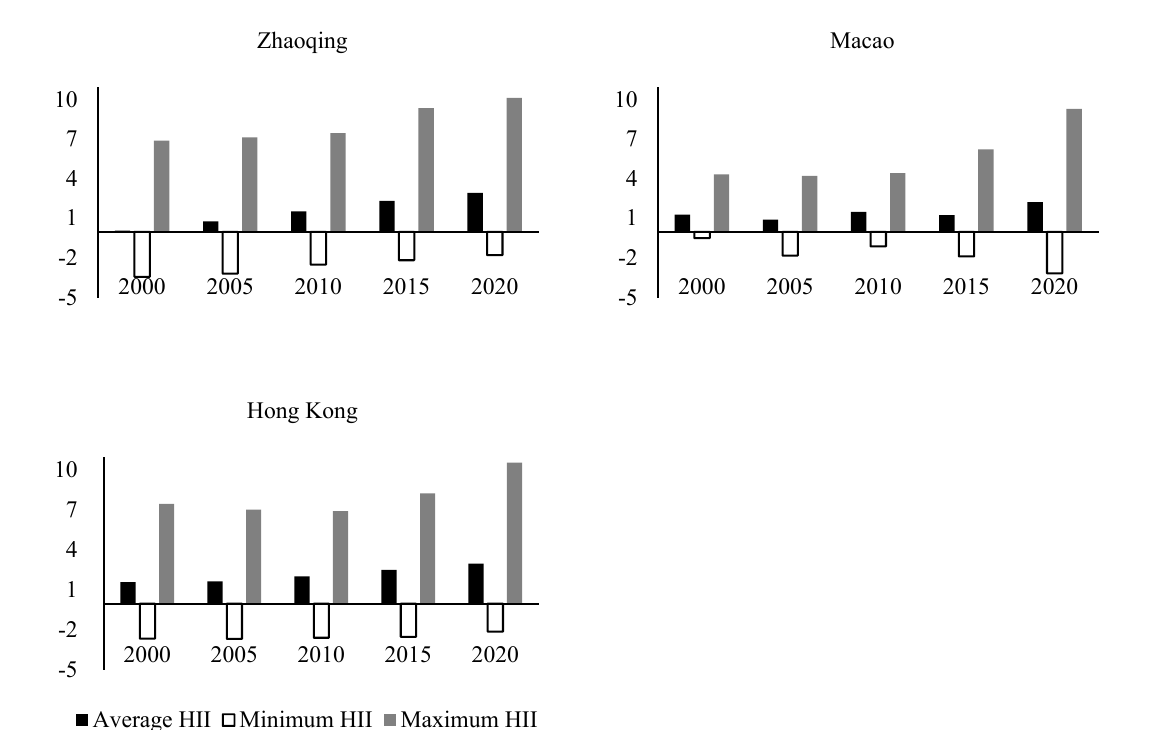
Figure 7. The changes in the average, minimum and maximum value in eleven cities of GBA from 2000~2020.